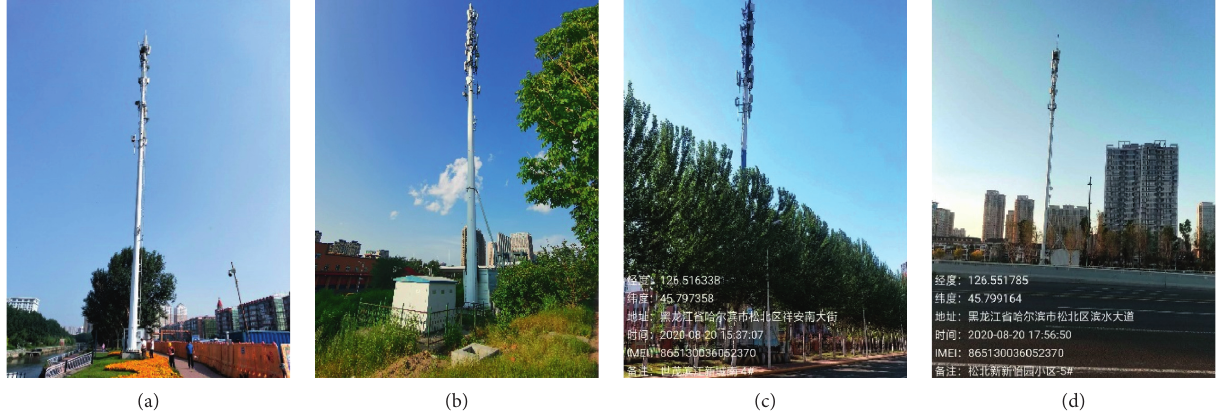
Figure 1: Photographs of four towers monitored within one cluster.